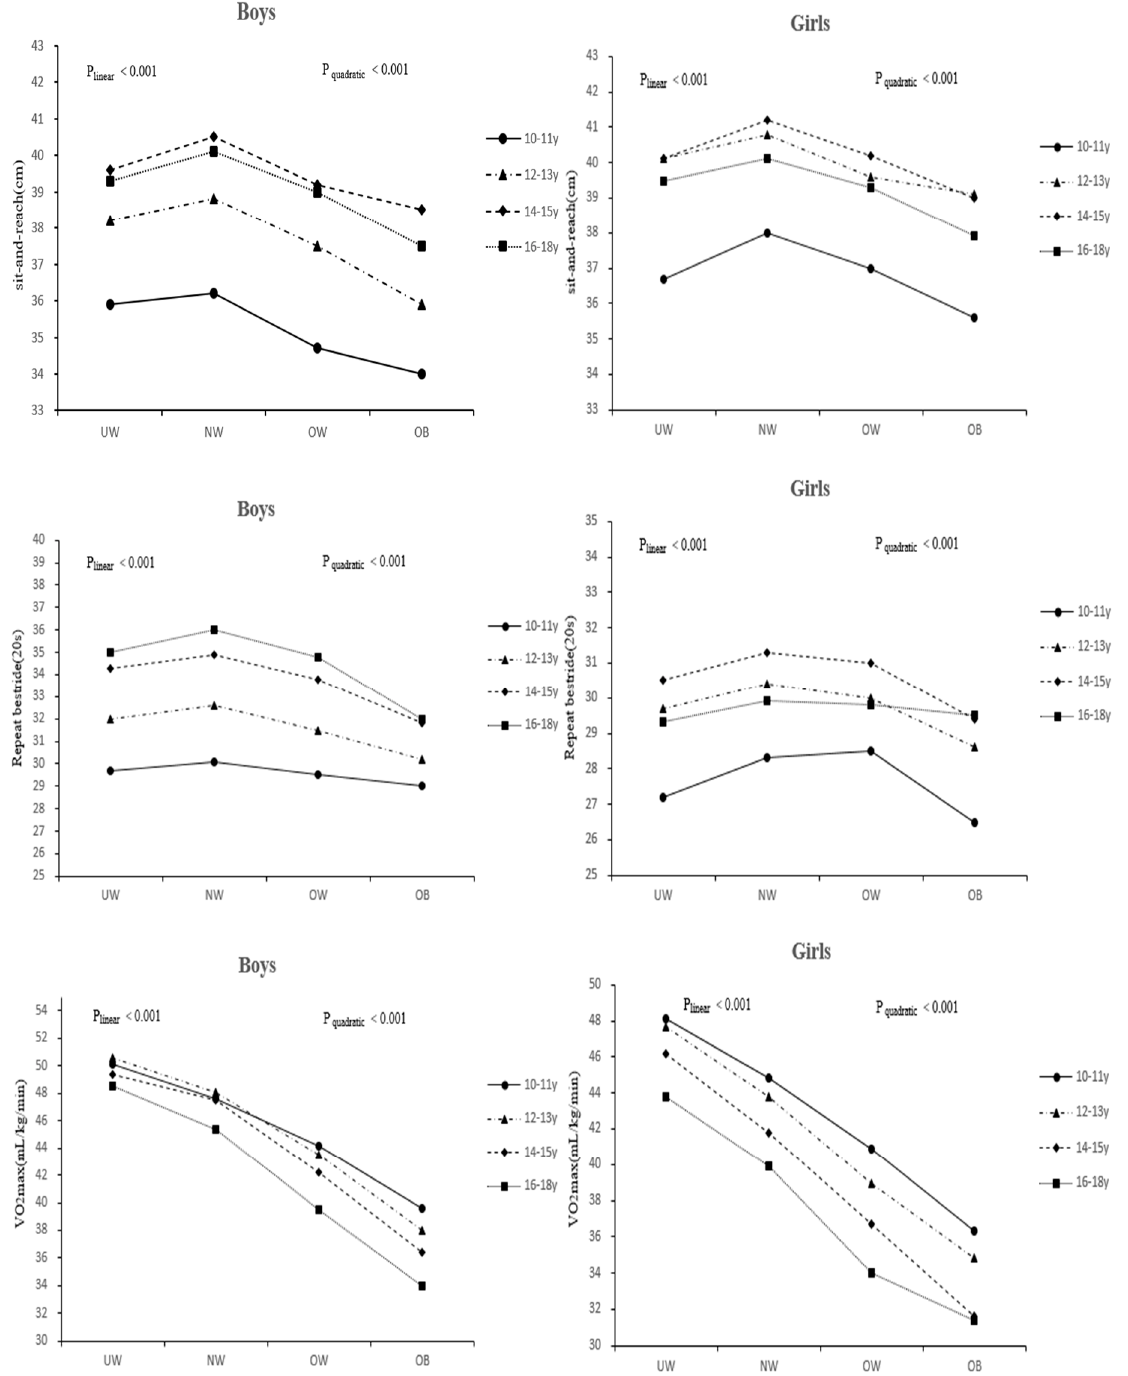
Figure 1. Association of physical fitness in boys and girls across BMI categories in adolescents. p linear and p quadratic refer to p -values obtained from ANCOVA analysis for linear and quadratic term. UW = underweight; NW = normal weight; OW = overweight; OB = obese.